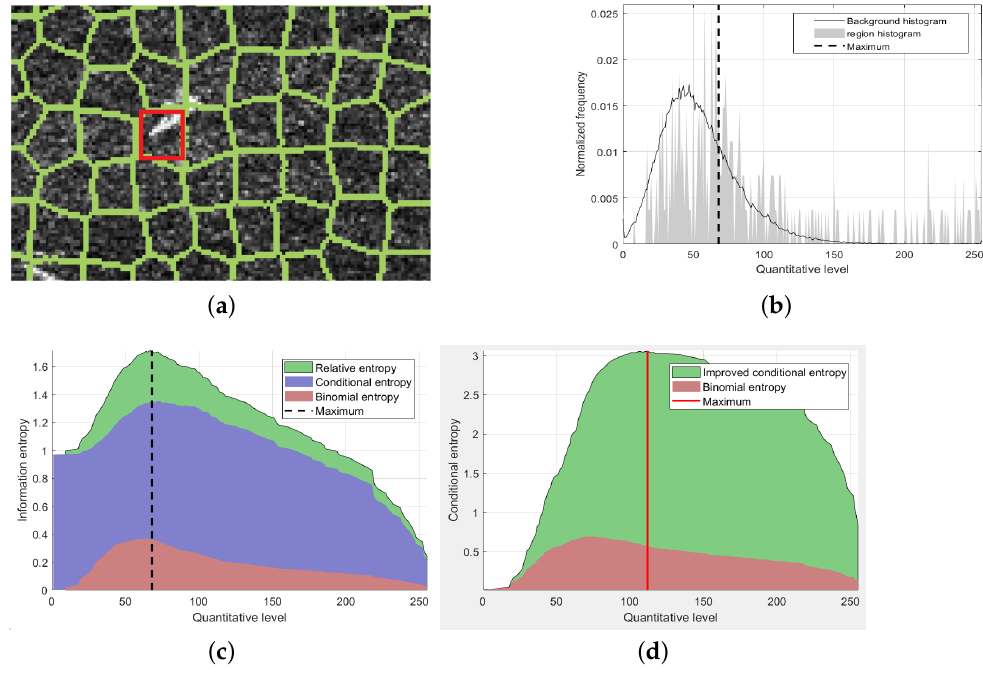
Figure 2. Conditional entropy of SAR image region. ( a ) Select area, ( b ) Normalized histogram of region and background, ( c ) Relative entropy, conditional entropy and binomial entropy of K n , ( d ) Improved conditional